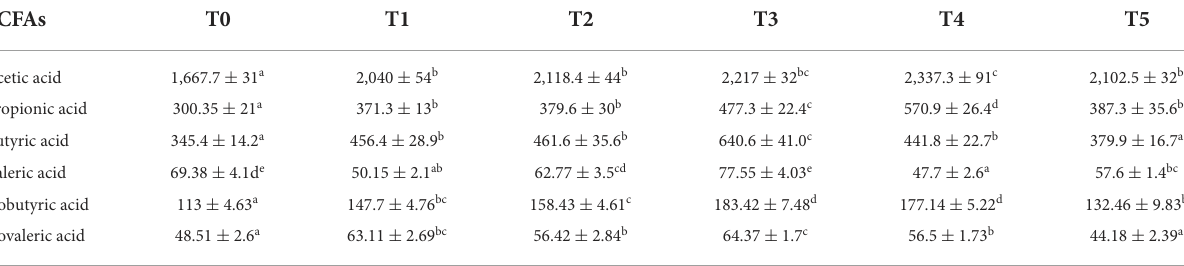
TABLE 7 Effects of adding CAP level ( µ g/L) on SCFAs in the plasma of white-feather broilers (means ± SEM). SCFAs